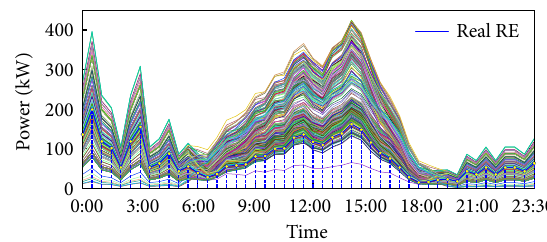
Fig. 5 Operating characteristics of the MT.